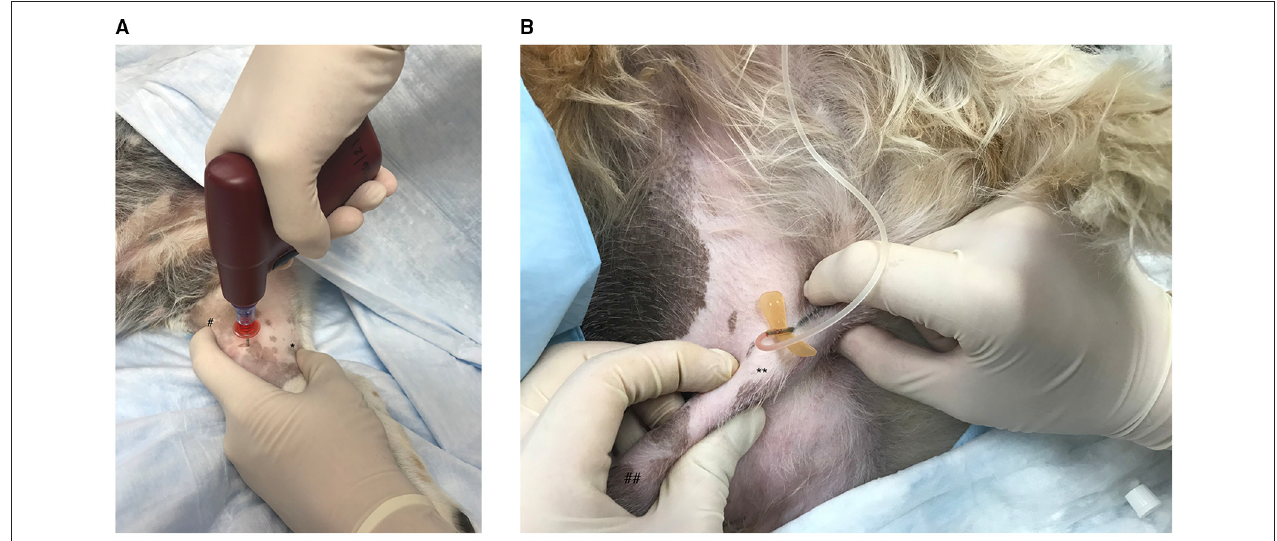
FIGURE 2 | (A) Emergency vascular access via intraosseous catheterization in the canine medial tibia using the EZ-IO G3 Power Driver (Vidacare Corp., Shavano Park, TX, USA). After aseptic preparation of the skin, a scalpel blade is used to make a small skin incision over the desired area. In a right-handed operator, the left index figure is used to palpate the patellar tendon (#) to identify and avoid the stifle joint then placed directly distal to the joint on the cranial aspect of the tibia. The left thumb is then used to identify and secure the caudal aspect of the tibia (*). The remaining fingers of the left hand are used to stabilize the distal tibia. The G3 Power Driver is held in the right hand and positioned perpendicular to the tibia. The catheter is then advanced through the bone until a drop in resistance indicates the catheter has entered the medullary cavity. The catheter should be well-seated in the bone. Bone marrow aspiration via a syringe confirms placement. A bolus of saline should flow easily, and the surrounding tissues should be closely monitored for extravasation. (B) Placement of a catheter in the corpus cavernosum of a male canine. With the patient in lateral recumbency, the penis is isolated within the prepuce at the level of the caudal os penis (**). The pars longa glandis is on the left (##). The needle is then inserted into the corpus cavernosum via the lateral aspect of the penis at an approximately 45 ◦ angle, directed caudally. Aspiration of blood and easy flow of saline through the catheter confirm